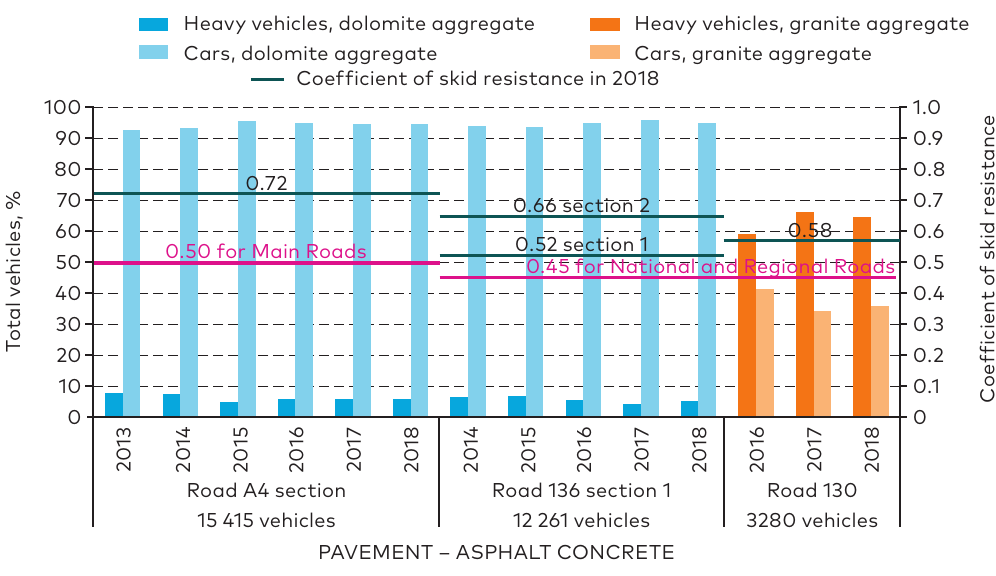
Figure 5. Research results on asphalt